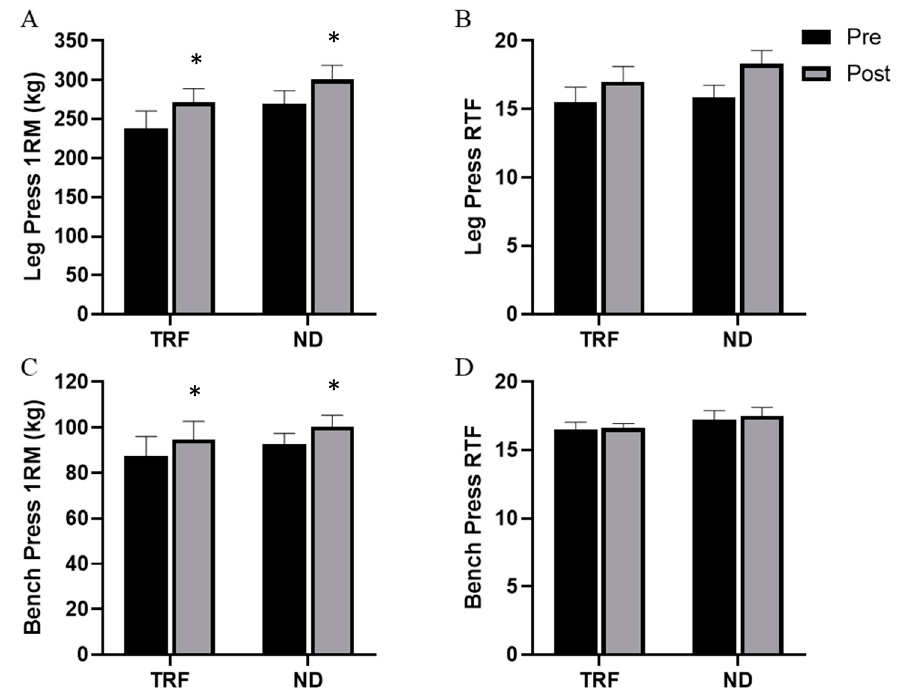
Figure 4. Leg press 1RM ( A ), leg press repetitions to failure ( B ), bench press 1RM ( C ), and bench press repetitions to failure ( D ) over the course of 4-weeks of the intervention from pre to post for both the time-restricted feeding (TRF) and normal diet (ND) groups. Error bars reflect SEM. * = main effect for time.